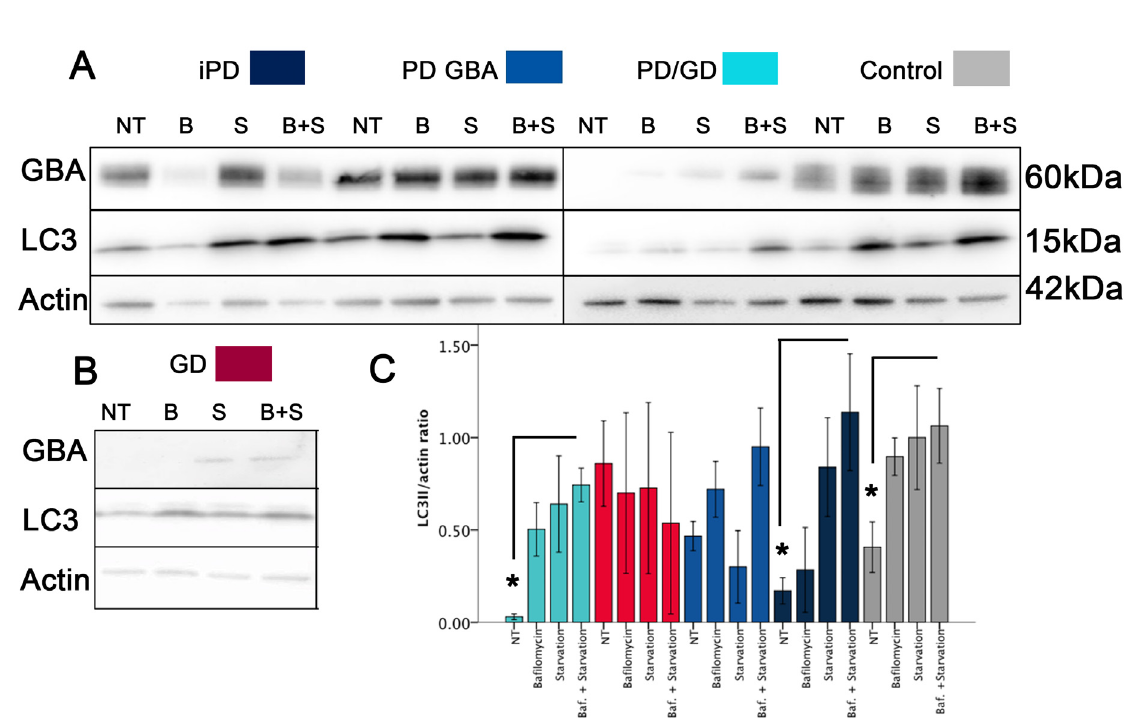
Figure 2. Autophagy assay in patient fibroblasts. ( A, B ) Western blot of LC3IIb and GBA for all patient lines. Ratio of LC3 IIb/actin for control (NT) (0.41 ± .14) compared to (B+S) (1.06 ± 0.20) (p=0.053), iPD (NT) (0.17 ± .07) compared to (B+S) (1.13 ± 0.32) (p=0.032). This was also true for PD/GD (NT) (0.03 ± 0.01) compared to (B+S) (0.74 ± 0.09) (p=0.048), PD GBA (NT) (0.50 ± 0.07) compared to (B+S) (0.95 ± 0.21). GD (NT) (0.86 ± 0.23) compared to (B+S) (0.54 ± 0.49) (p>0.05). Optical density of western blot bands was measured in Image J. ( C ) Data was analysed by ANOVA and Bonferroni post hoc test. Analysis was repeated in three independent experiments for each cell line. Data are presented as mean ± s.e.m.